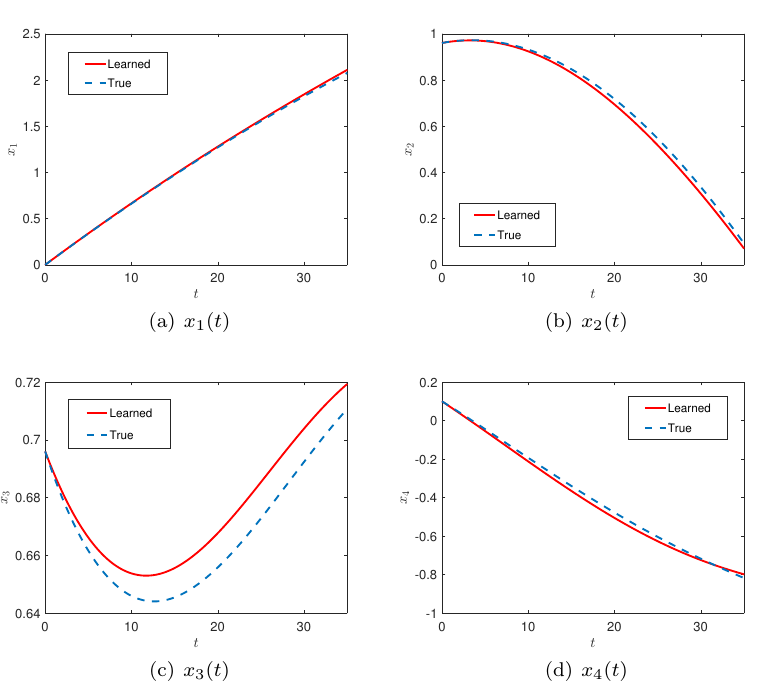
Fig. 1. Comparison between the trajectories of learned model (14) and true model